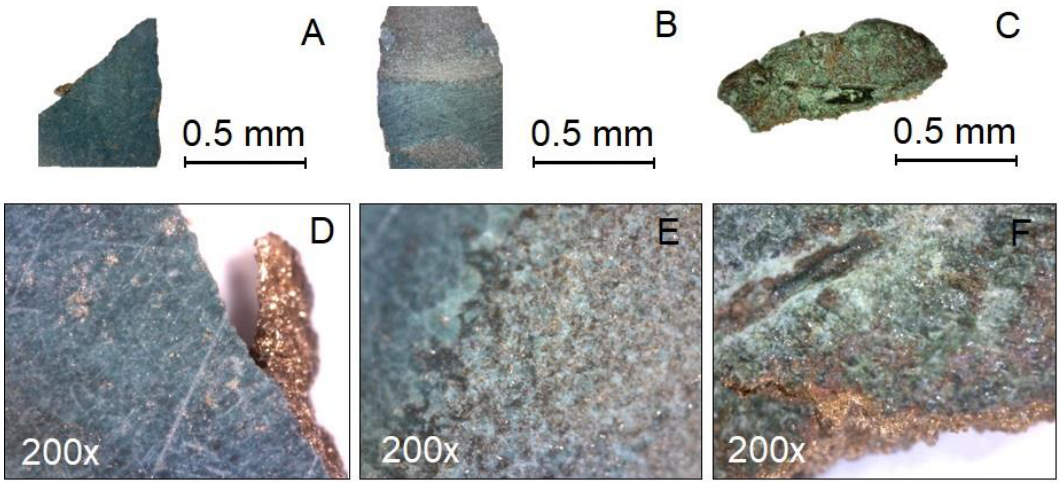
Figure 2. ( A , D ) F1 Fragments; ( B , E ) F2 fragments; ( C , F ) H1 fragments.